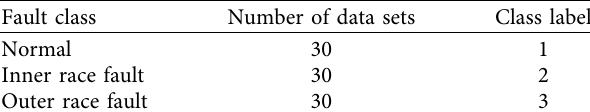
Table 4: Experimental data set.